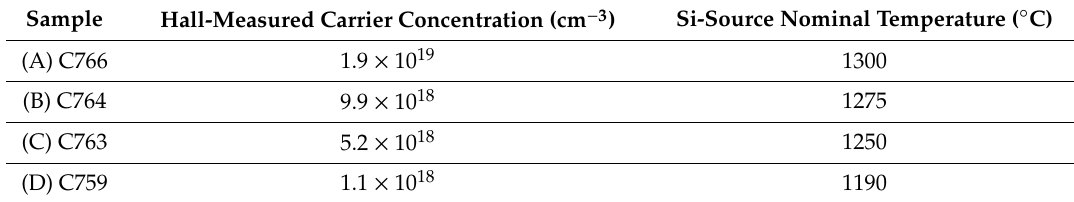
Table 1. The samples’